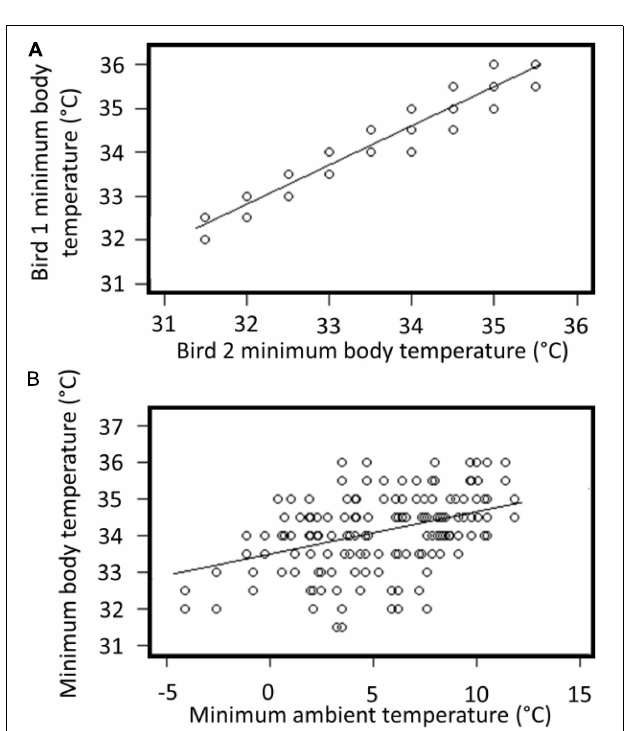
FIGURE 2 | (A) Ordinary least squares regression line of daily minimum body temperature ( ◦ C) of tawny frogmouth 1 and daily minimum body temperature (C ◦ ) of tawny frogmouth 2 ( n = 88 days, points overlap). (B) Ordinary least squares regression line of daily minimum body temperature ( ◦ C) of two tawny frogmouths and daily minimum air temperature ( ◦ C).